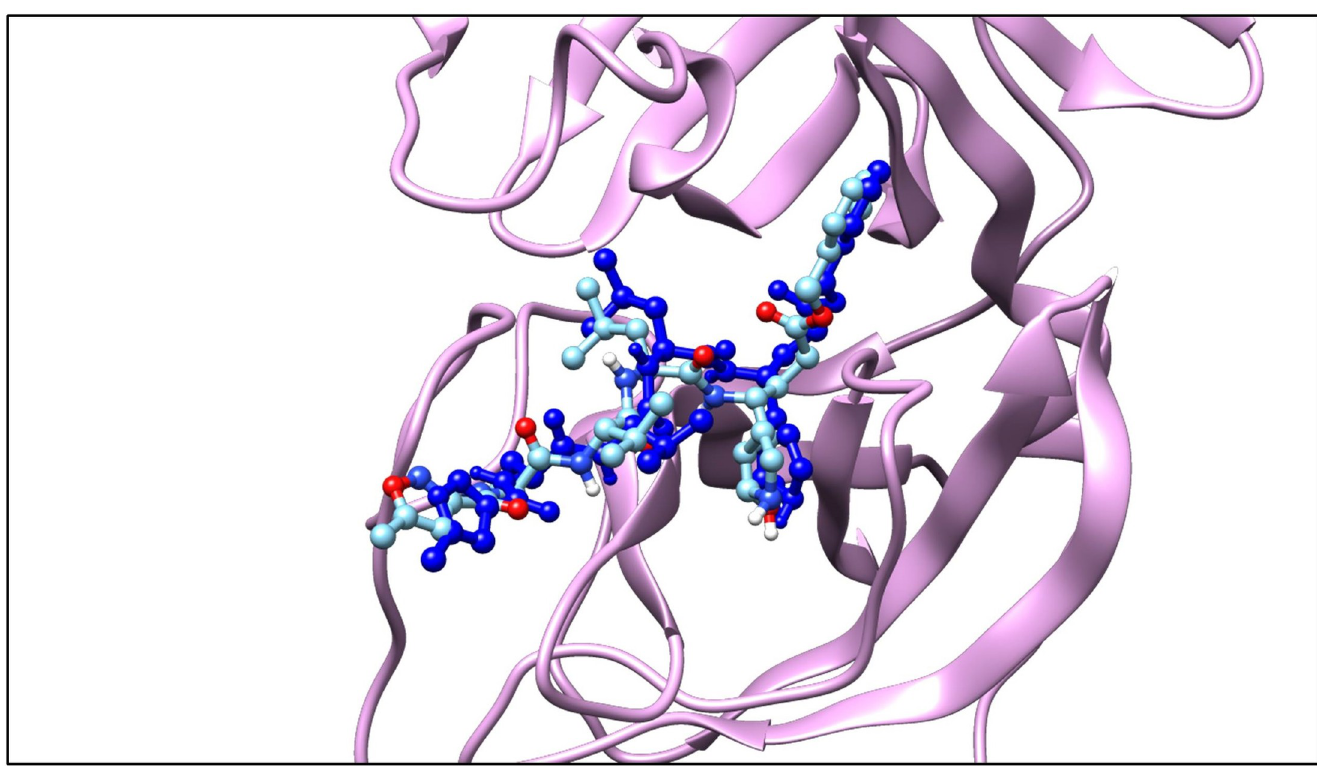
Fig 15. The molecular structures of native ligand binding to receptor in SARS-CoV-2.